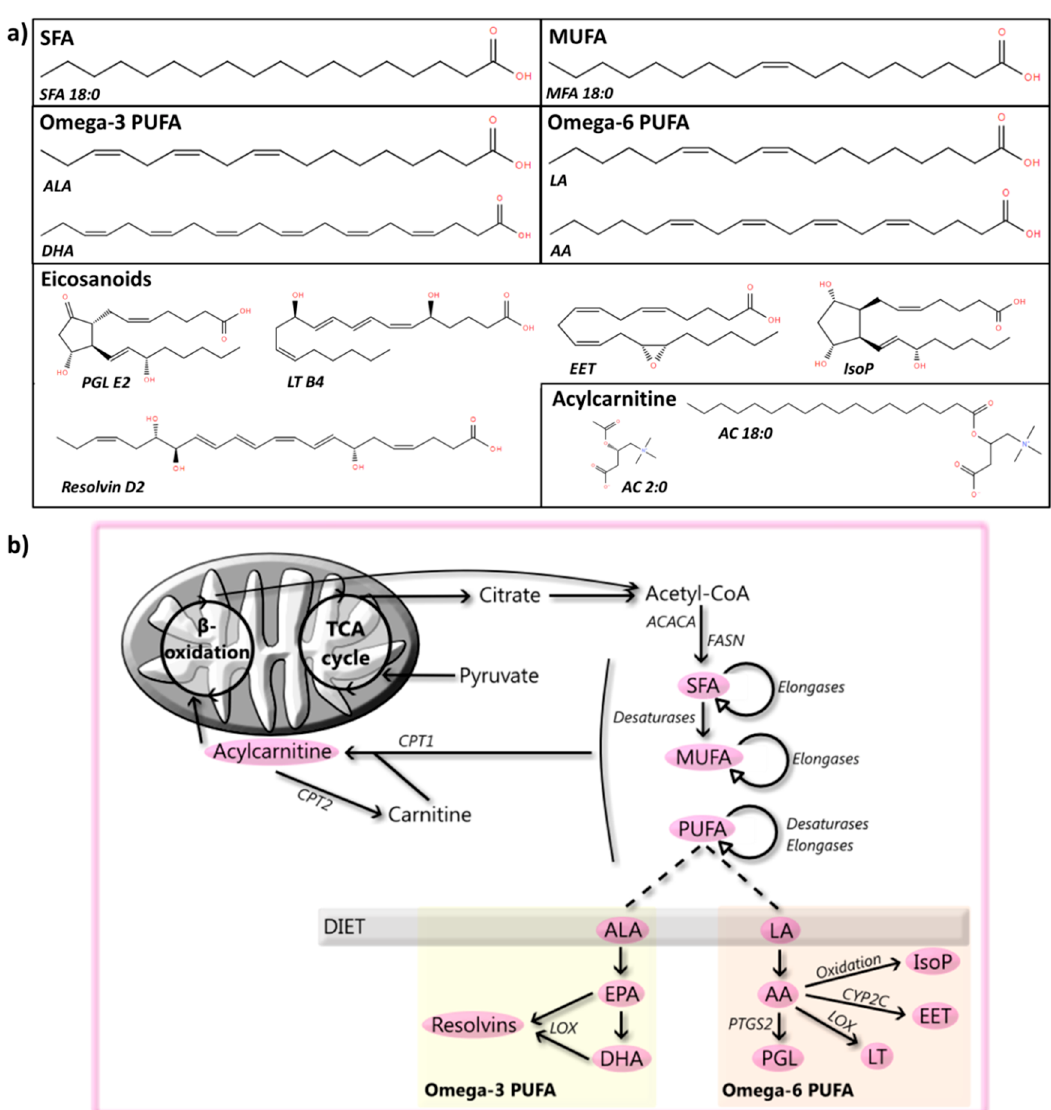
Figure 2. Fatty acyls: structures and metabolic steps involved. ( a ) Schematic representation of the chemical structures of fatty acyls, including saturated fatty acids (SFA 18:0), monounsaturated fatty acids (MUFA 18:1), omega-3 polyunsaturated fatty acids (PUFA, alpha-linoleic acid (ALA, top) and docosahexaenoic acid (DHA, bottom)), omega-6 PUFA (linoleic acid (LA, top) and arachidonic acid (AA, bottom)), eicosanoids (from left to right, prostaglandin E2 (PGL E2), leukotriene B4 (LT), 14,15-Epoxyeicosatrienoic acid (EET), 15-F2t-Isoprostane (IsoP), and resolvin D2 (bottom)), and acetylcarnitine (AC 2:0) and acylcarnitine (AC 18:0). Chemical structures are adapted from the LIPID MAPS structure database [25]. ( b ) Schematic overview of steps involved in the metabolism of fatty acyls, where fatty acids (FAs) can be obtained through the diet or by a multi-enzymatic reaction starting from acetyl-CoA and performed by enzymes such as acetyl-CoA carboxylase 1 (ACACA) and fatty acid synthase (FASN). Multiple steps of elongation, performed by elongases, and desaturation, carried out by desaturases, produce MUFA and PUFA. PUFA include, among others, omega-3 PUFA, such as ALA, which can be converted by a multistep reaction into eicosapentaenoic acid (EPA) and DHA, and omega-6 PUFA, including LA, which can be transformed by a multistep reaction to AA. PUFA can be further metabolized by enzymes such as lipoxygenase (LOX), prostaglandin-endoperoxide synthase 2 (PTGS2, also known as COX2), cytochrome p450 2C to various eicosanoids, including resolvins, PGL, LT, EET, or oxidized to isoP. Furthermore, transport of FA into mitochondria for their metabolism is preceded by their association with carnitine, which is catalyzed by the enzyme carnitine O-palmitoyltransferase 1 (CPT1) and reversed by carnitine O-palmitoyltransferase 2